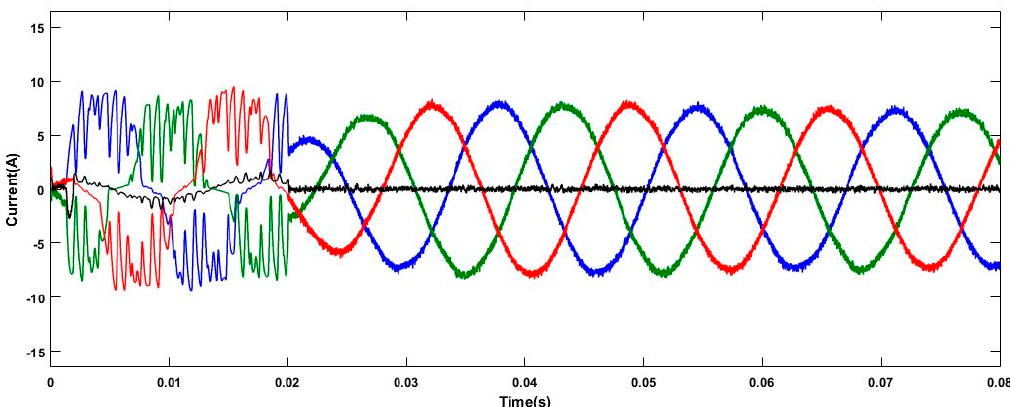
Figure 12. Compensation result with the sliding DFT for case 2.